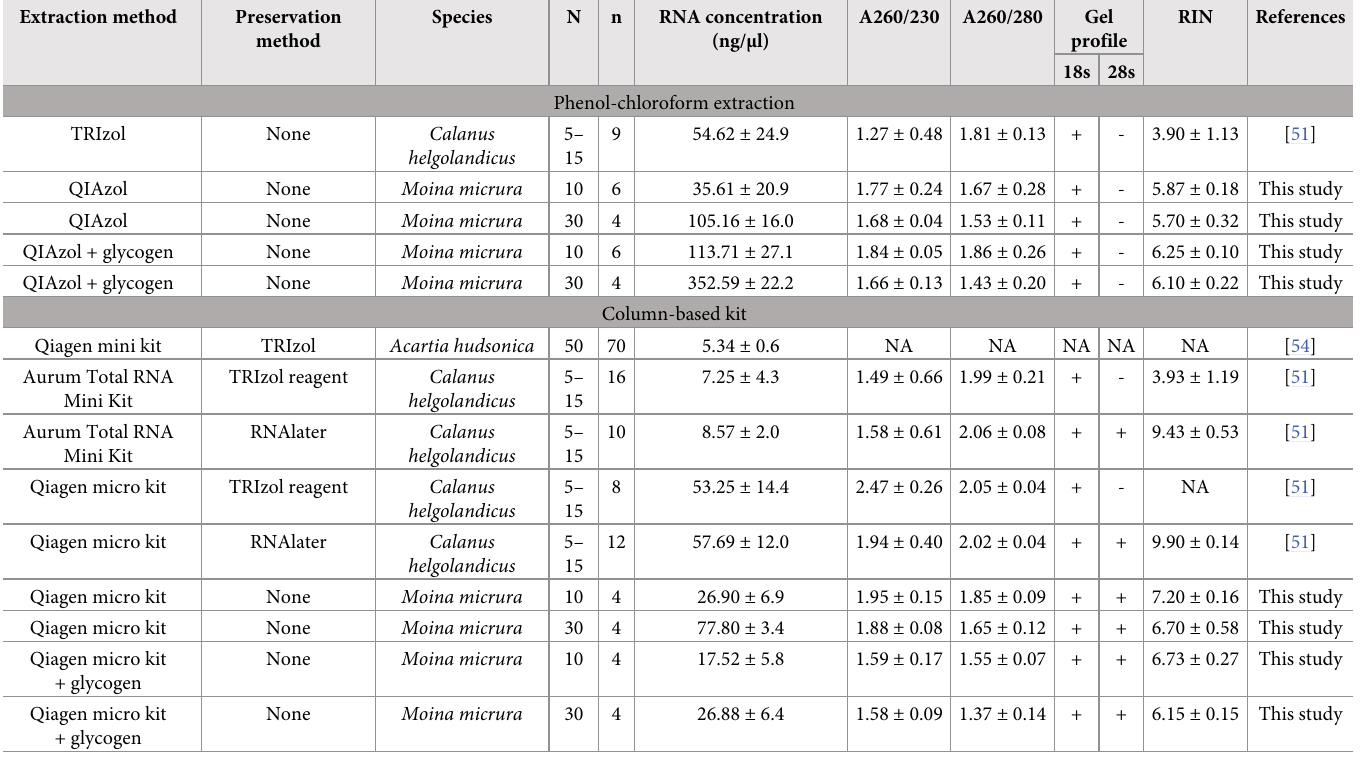
Table 3. The comparison of quantity (ng/individual), purity (A260/230 and A260/280 ratios) and integrity (RIN values), of total RNA extracted from zooplankton using different extraction and preservation methods. Extraction